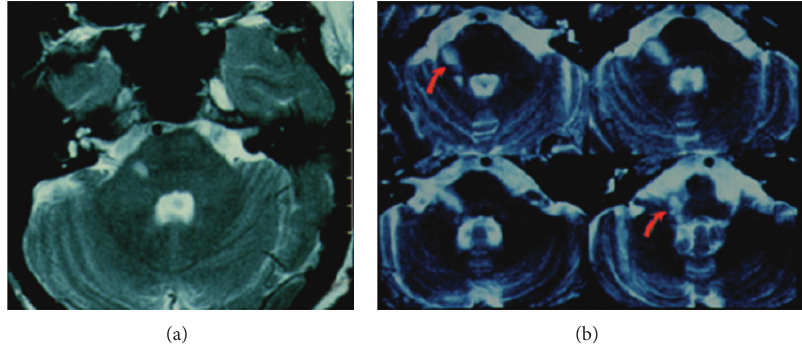
Figure 1: (a) (MRI-T2 image) Fascicular and nuclear lesion of the vestibular nerve due to a multiple sclerosis plaque mimicking vestibular neuritis. (b) (MRI-T2 image) Fascicular and nuclear lesion of the vestibular nerve due to a vascular lesion mimicking vestibular neuritis.